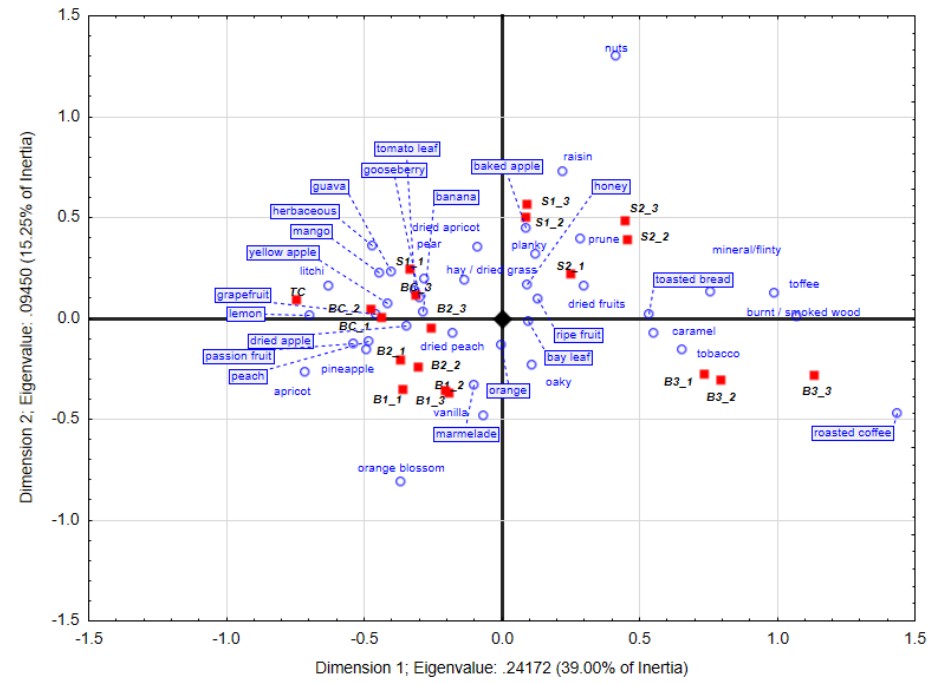
Figure 1. Correspondence analysis obtained with the trained panel ( n = 20) after 4 months of oak maturation from Pick K data. Certain descriptors (boxed) have been moved to improve the readability of the plot. TC: tank control, BC: barrel control, B: new barrel treatments, S: stave treatments.